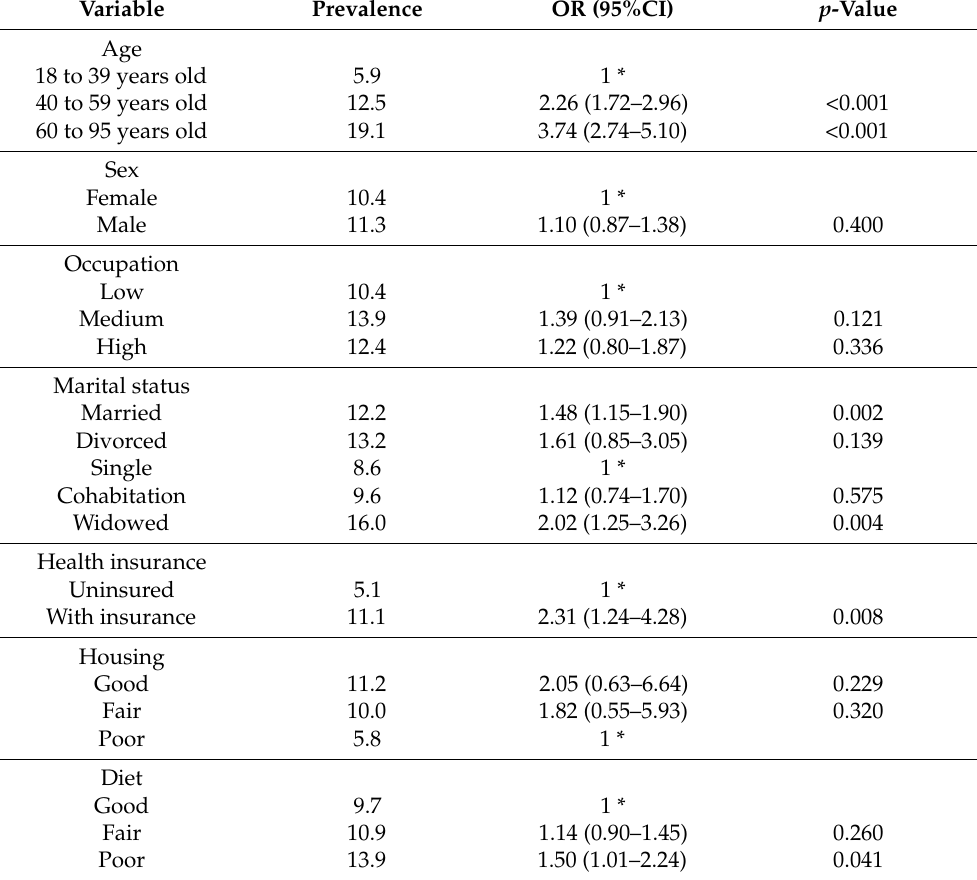
Table 2. Bivariate logistic regression analysis for diabetes and independent variables.